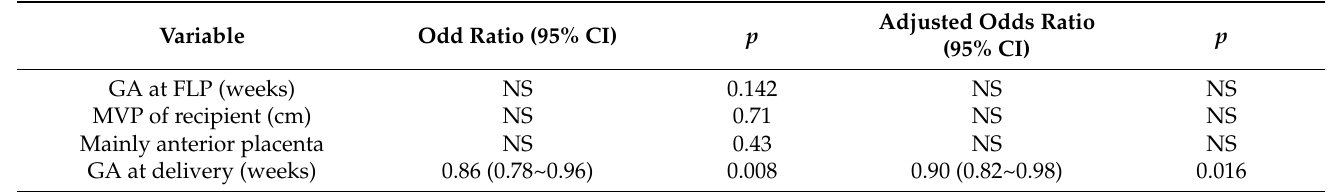
Table 7. Variables for neonatal brain sonographic anomalies in patients with TTTS treated using